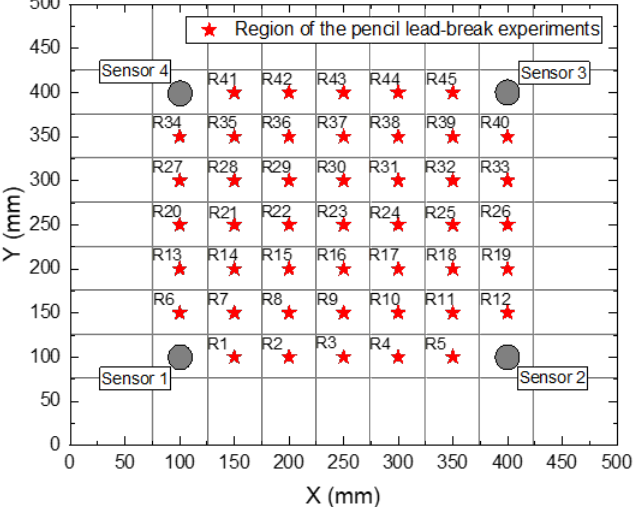
Figure 2. Schematic illustration of the area of the pencil lead break on the aluminum alloy plate/composite laminate.